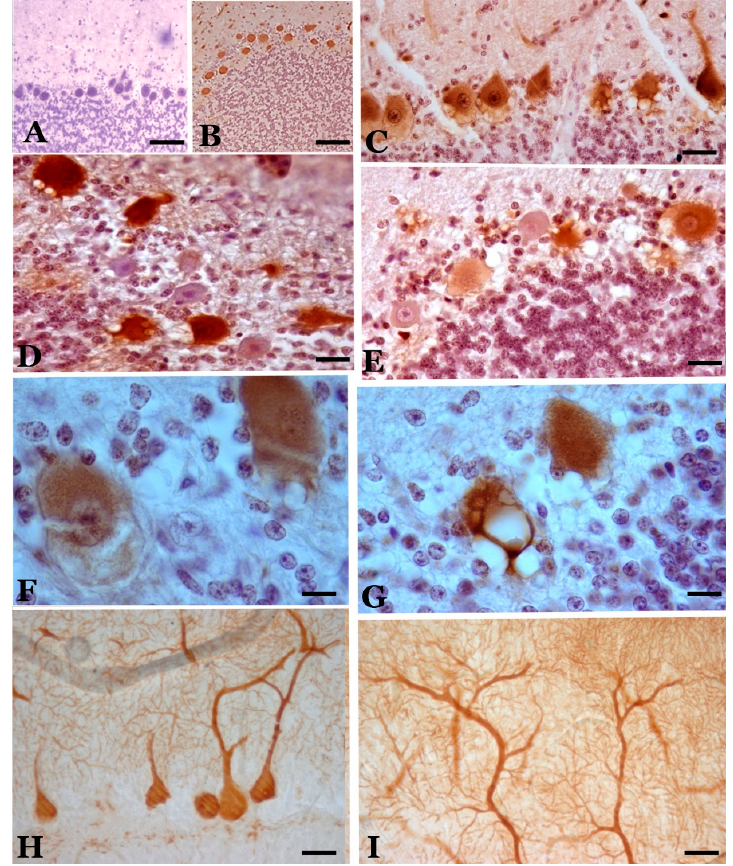
Figure 2. Calbindin ‐ immunopositive Purkinje cells in control ( A ) and scrapie ‐ affected sheep ( B – I ). ( B ) Cells of normal appearance in a case of preclinical scrapie, with a similar pattern to the control cases. ( C ) Cells of different appearance (normal, hypertrophic, dystrophic with rarefaction of their cytoplasm) in a case of clinical scrapie. ( D , E ) Cells of very different immunoreactivity in two cases of terminal scrapie. ( F ) Cytoplasmic rarefaction of the basal cytoplasm in an immunopositive cell of clinical scrapie. ( G ) Intense vacuolization in a positive cell. ( H , I ) Hypertrophic/hyperreactive cells. In ( H ), the hypertrophy of the initial dendrites is shown, and in ( I ), the hypertrophy of the distal dendrites that reach the pia mater. ( A – F ), hematoxylin contrast; ( H , I ), without contrast. (Bar: A, B = 125 μ m; C–E = 25 μ m; F, G = 20 μ m; H,I = 30 μ m).